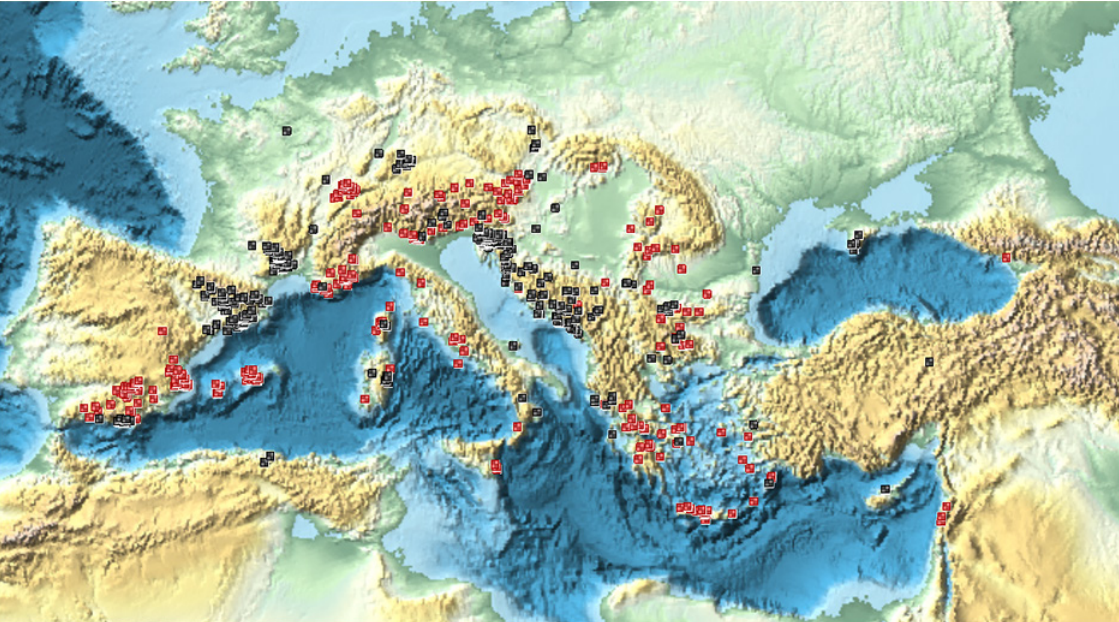
Fig. 212. Distribution map of species of Plusiocampinae Paclt, 1957 with medial posterior (or intermediate) notal macrosetae (red squares) and without these macrosetae (black